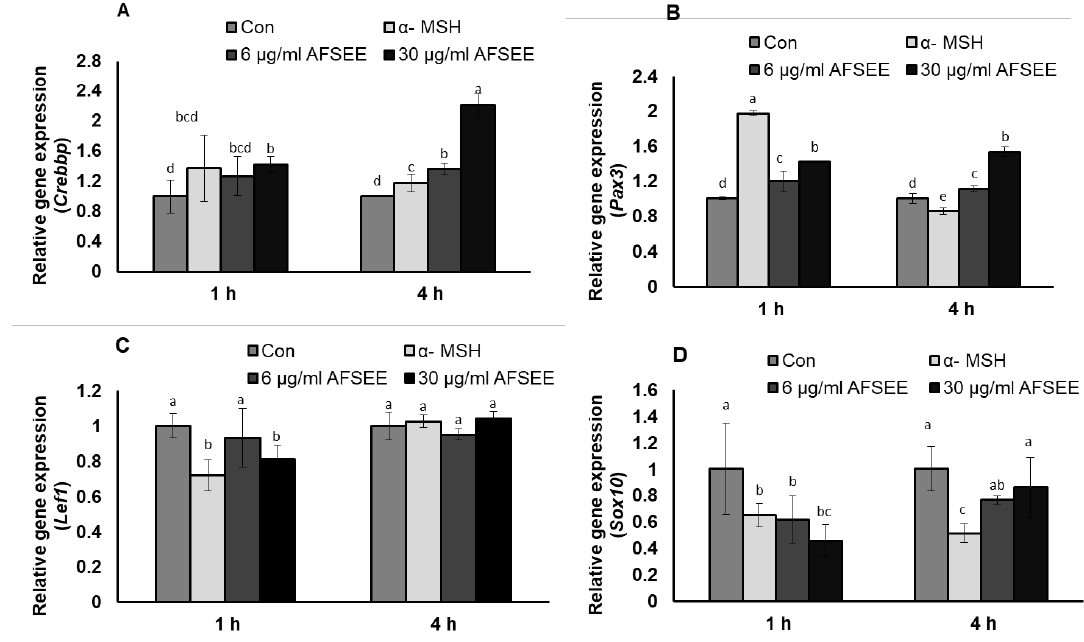
Figure 8. E ff ect of argan fruit shell ethanol extract (AFSEE) on mRNA expression of CREB binding protein ( Crebbp ), paired box gene 3 ( Pax3 ), lymphoid enhancer binding factor 1 ( Lef1 ), and SRY box-containing gene 10 ( Sox 10 ). B16F10 cells were cultured in a 100 mm dish at a density of 3 × 10 5 cells / dish and treated without (control) or with α -MSH (200 mM) or AFSEE (6 µ g / mL and 30 µ g / mL) for 1 h and 4 h ( A ) The e ff ect of AFSEE on Crebbp , ( B ) Pax3 , ( C ) Lef1 , and ( D ) Sox10 expression was quantified using TaqMan real-time PCR. Data were subjected to ANOVA ( n = 4). All comparisons were made between treatments. Di ff erent letters indicate treatment di ff erences at the p ≤ 0.05 level.